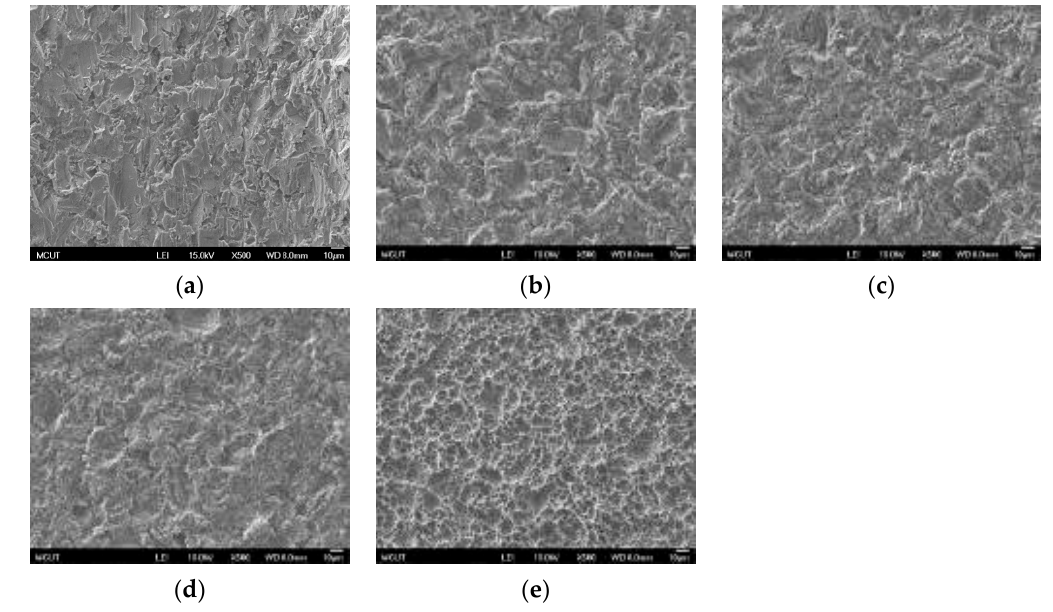
Figure 7. SEM images of CP Ti surface after a single acid etching at RT and at BT (500× magnification): ( a ) sandblasting; ( b ) H 2 SO 4 for 10 min; ( c ) HCl for 10 min; ( d ) H 2 SO 4 (120 °C) for 10 min; and ( e ) HCl (80 °C) for 10 min. Materials 2017 , 10 , 1164